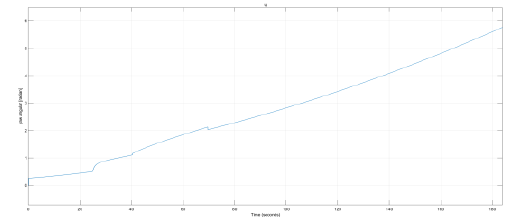
Figure 22. Z distance response for the QAV